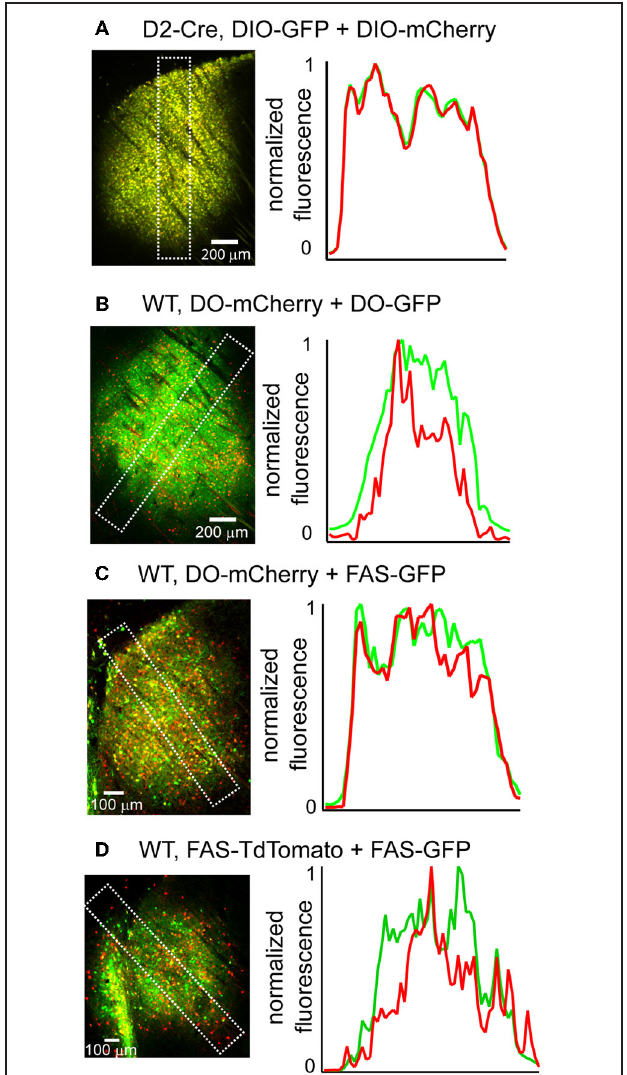
FIGURE 6 | Co-infection with DIO or DO/FAS rAAVs drives co-expression without spatial interference. (A) Infection of multiple DIO Cre-On rAAVs results in co-expression of transgenes without interference. Left , a sagittal section of a D2-Cre mouse infected with DIO-GFP and DIO-mCherry in the striatum. Right , normalized mean fluorescent values for GFP and mCherry quantified from boxed inset in A . (B–D) Infection of multiple Cre-Off rAAVs results in co-expression of transgenes without spatial interference. Left , sagittal sections from wild type mice infected with B . DO-mCherry + DO-GFP, C . DO-mCherry + FAS-GFP, or D . FAS-TdTomato + FAS-GFP in the striatum. Right , normalized mean fluorescent values for GFP and mCherry/TdTomato quantified from boxed inset in to the